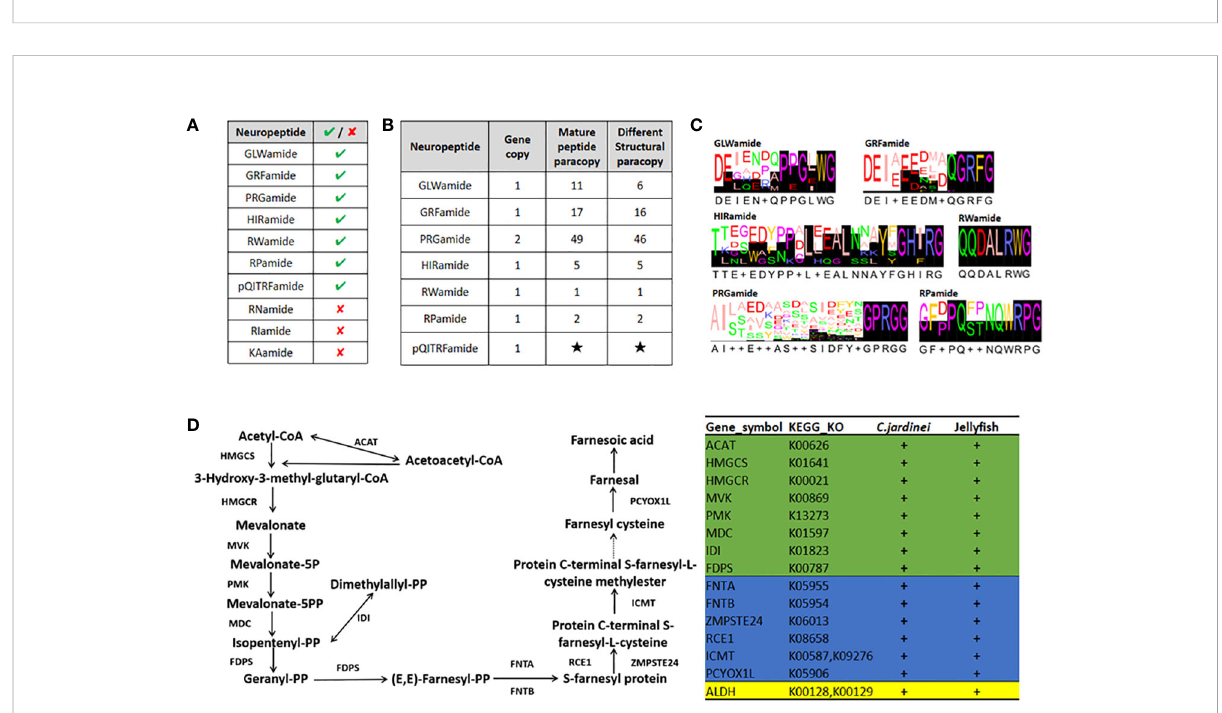
FIGURE 4 (A) The presence of anthozoan neuropeptides identi fi ed in C jardinei ; (B) The numbers of mature peptides identi fi ed in each Scleratinian neuropeptides. Black star indicates unknown number due to its absence in the transcriptome. (C) The sequence logos of the Scleratinian conserved mature neuropeptides identi fi ed in C jardinei . (D) Schematic diagram showing the sesquiterpenoid hormone biosynthetic pathway in cnidarians. “ + ” sign denotes the presence of particular gene in respective class. The green background refers to genes in the mevalonate pathway, while the blue and yellow backgrounds refer to genes in the different downstream pathways. ACAT, Acetyl-CoA acetyltransferase, HMGCS, 3-hydroxy-3-methylglutaryl-CoA synthase, HMGCR, 3-hydroxy-3-methylglutaryl-CoA reductase, MVK, Mevalonate kinase, PMK, Phosphomevalonate kinase, MDC, Mevalonate (Diphospho) decarboxylase, IDI, Isopentenyl-diphosphate delta isomerase, FDPS, Farnesyl diphosphate synthase, FNTA, Farnesyltransferase, CAAX box, alpha, FNTB, Farnesyltransferase, CAAX box, beta, ZMPSTE24, STE24 endopeptidase, RCE, prenyl protein protease, ICMT, isoprenylcysteine carboxyl methyltransferase, PCYOX1L, Prenylcysteine oxidase 1, ALDH, Aldehyde